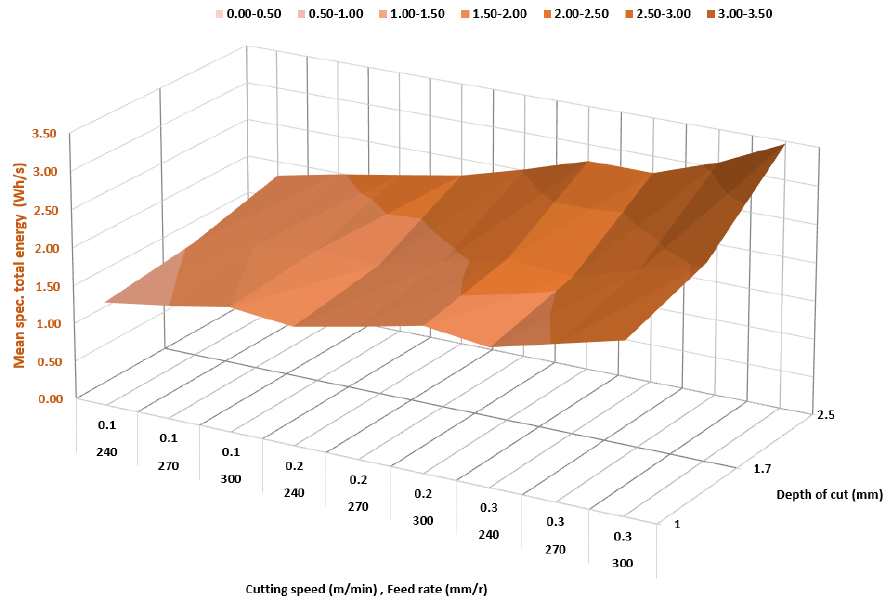
Figure 9. Total time-specific energy consumption (STEC) in relation to the selected range of a p , f , v c .